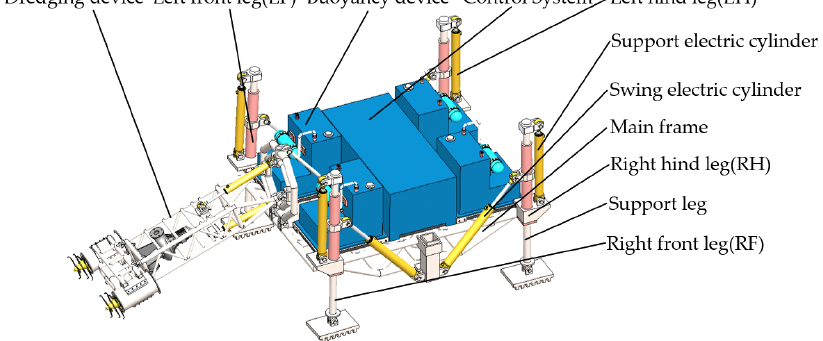
Figure 2. Three-dimensional schematic diagram of dredging robot.